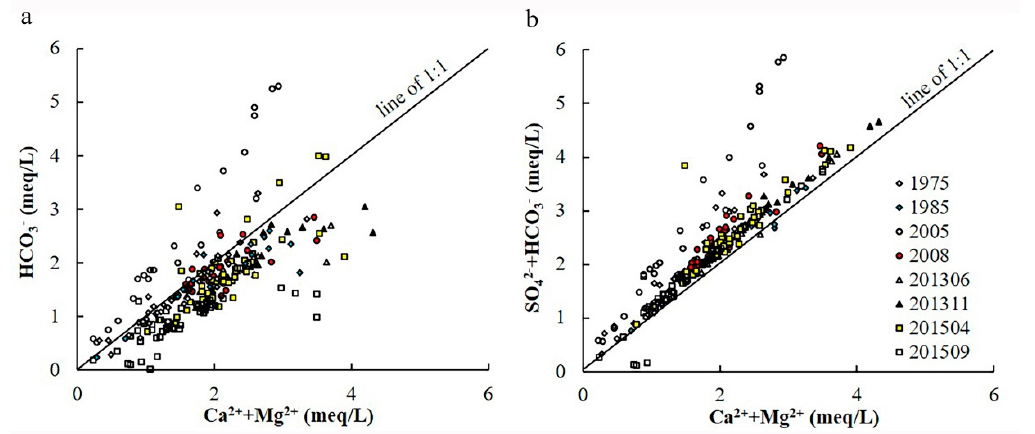
Figure 6. Scatter diagrams showing the relationship between Ca 2 + + Mg 2 + vs. ( a ) SO 42 − + HCO 3 − and ( b ) HCO 3 − after correction for atmospheric input for all sampling periods (meq /